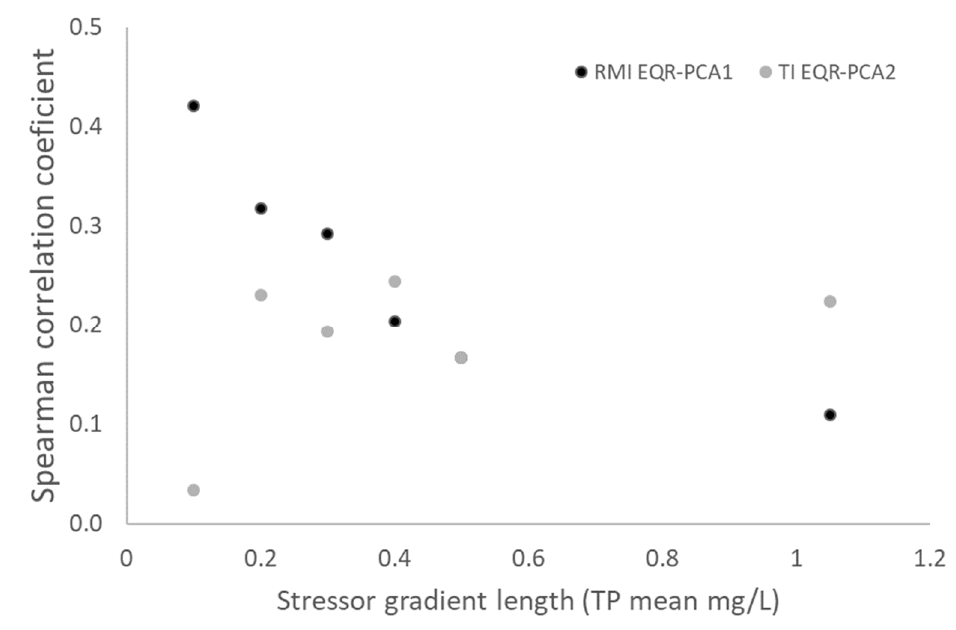
Figure 8. Changes in the correlation coefficient between the first and second axes of the Principal Component Analysis (PCA) and the River Macrophyte Index (RMI EQR) and Trophic index (TI EQR), respectively, as a function of the stressor gradient length expressed as the total phosphorous—annual mean (TP mean).